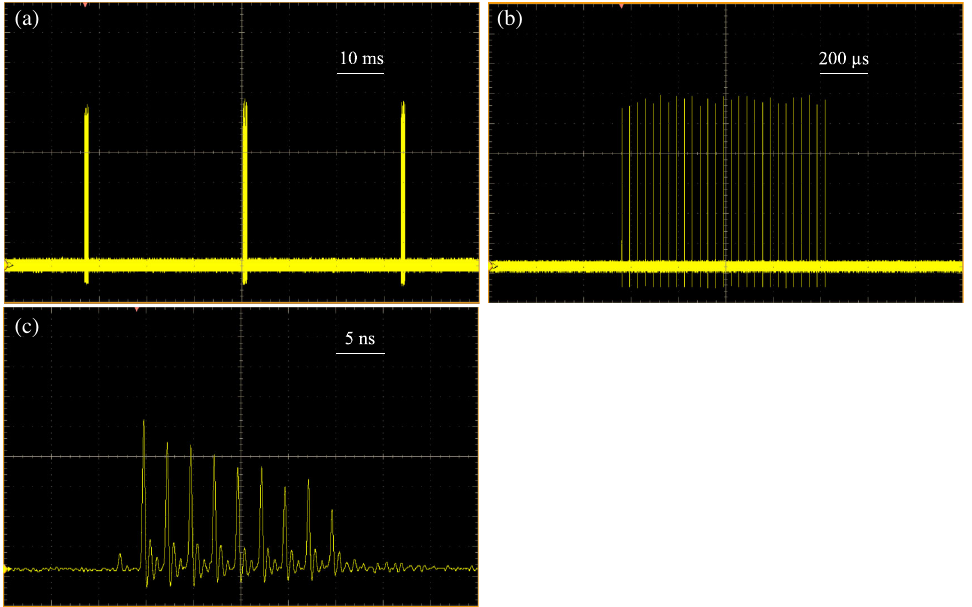
FIG. 6. Laser comb waveforms. (a) 30-Hz macropulses, (b) individual laser comb with a comb span of 35 minipulses ( ∼ 33 us) consisting of 27 comb teeth, (c) micropulses within one laser comb tooth. Overshoot in the waveforms is due to the limited bandwidth of the